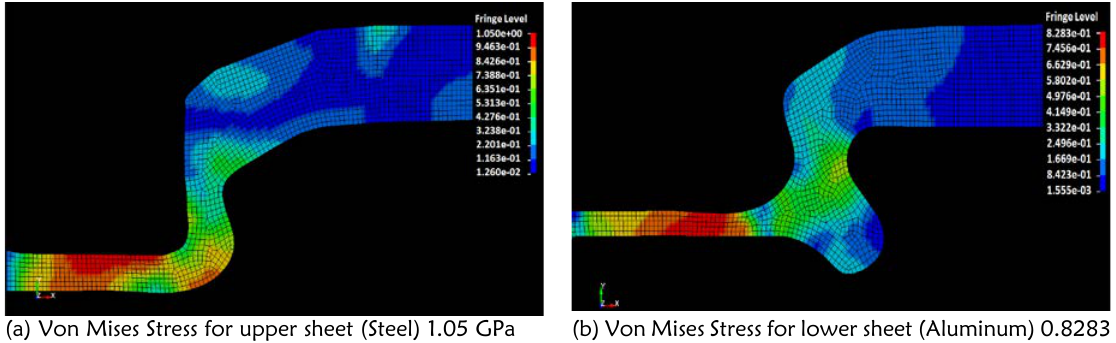
Figure 1: The Equivalent Von Mises Stresses and the total Equivalent Plastic Strain obtained from LS-DYNA (2D axis symmetric Clinching forming